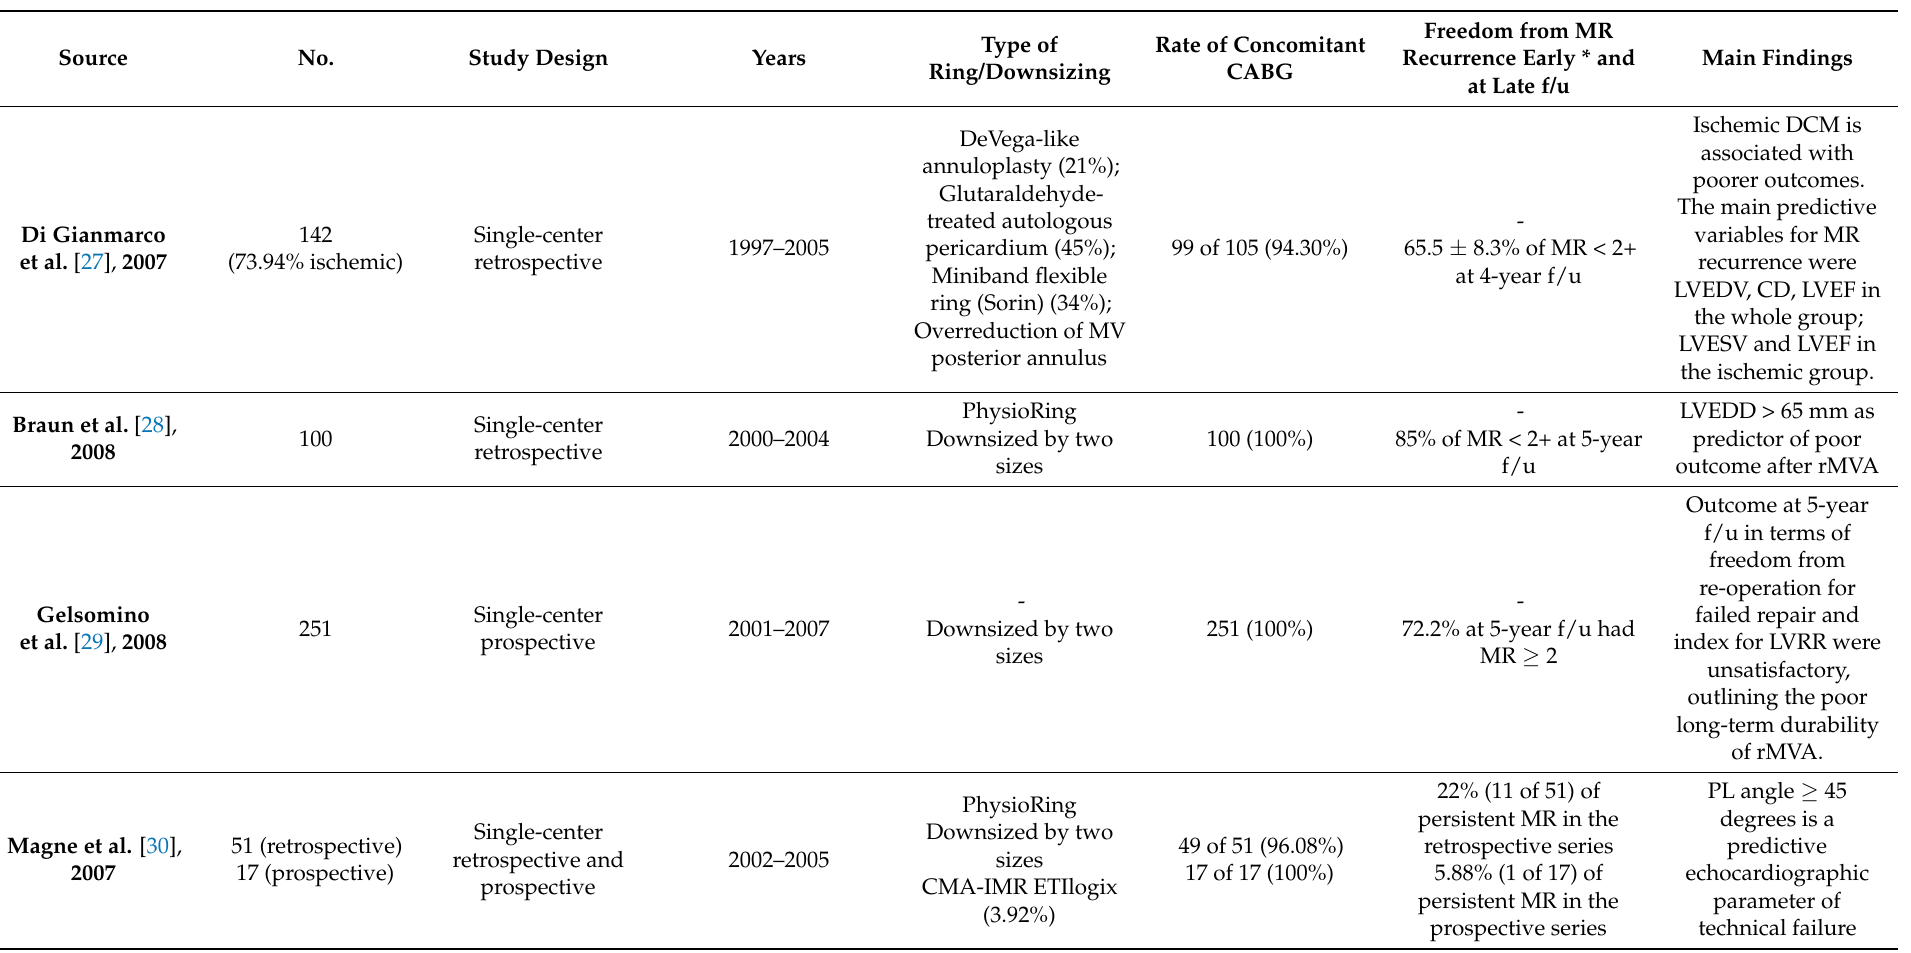
Table 2. Findings from major studies evaluating the effectiveness in terms of freedom from mitral regurgitation recurrence after mitral valve annuloplasty (MVA) in the management of severe secondary mitral regurgitation (SMR), further reporting analyzed clinical